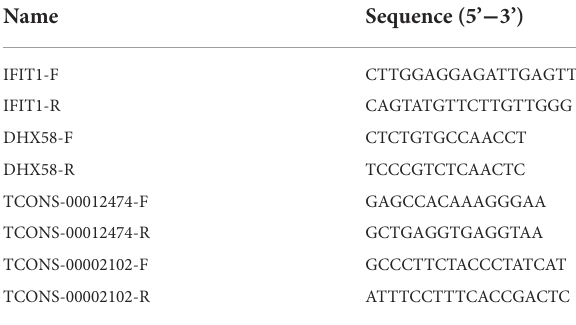
TABLE 1 Forward and reverse primers used for gene quantification by